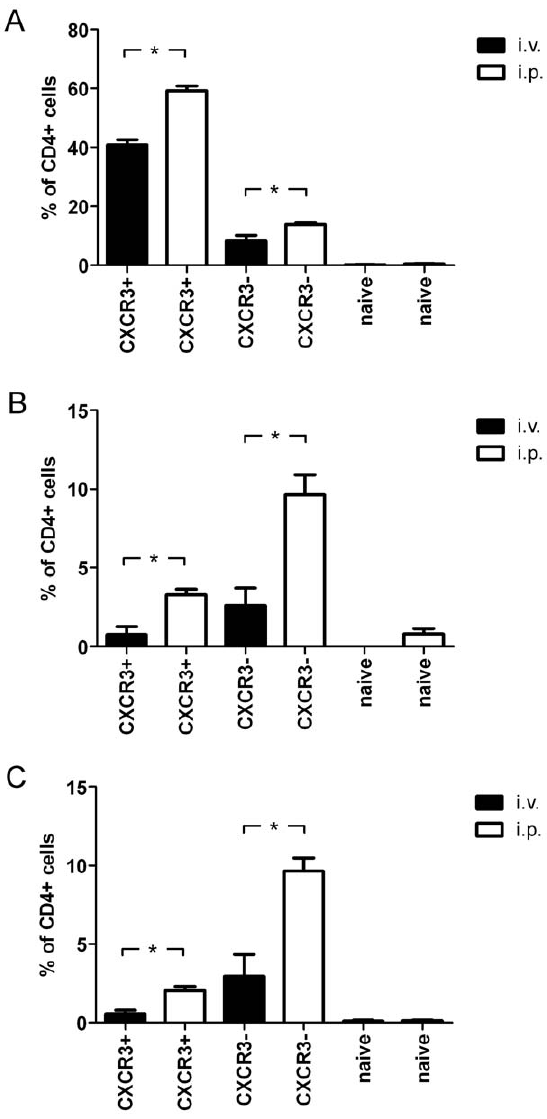
Figure 8. The environment of the PerC results in increased expression of IFN c by CD4 + T cells. CXCR3 + CD62L low CD44 high , CXCR3 2 CD62L low CD44 high and CXCR3 2 CD62L high CD44 low CD4 + T cells were sorted from Sp of naı¨ve C57BL/6 mice and stained with CFSE. Then, cells were transferred to naı¨ve recipient animals by i.v. or i.p. rout and re-isolated after 24 h. Cells were re-stimulated with ionomycin, PMA and brefeldinA, stained for (A) IFN c , (B) IL-4 and (C) IL-17 production and further analyzed by flow cytometry. The percentage of cells producing the different cytokines was subsequently determined. Similar results were obtained in 2 independent experiments. The differences were statistically significant at P , 0.01